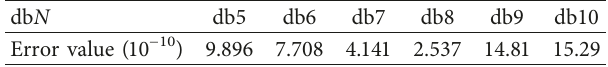
Table 4: Reconstruction errors of wavelet packet analysis.